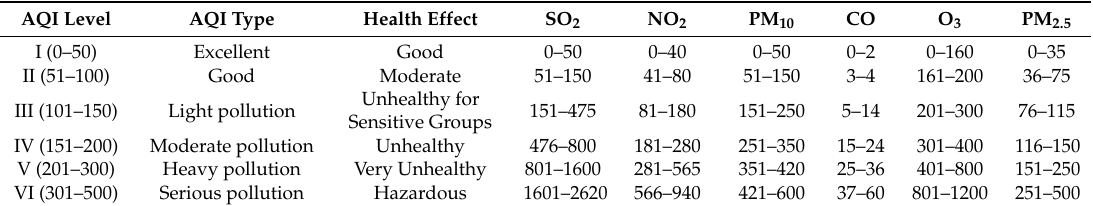
Table 1. Characteristics of air quality index (AQI) and individual AQI (IAQI) concentration limits in China. AQI Level AQI